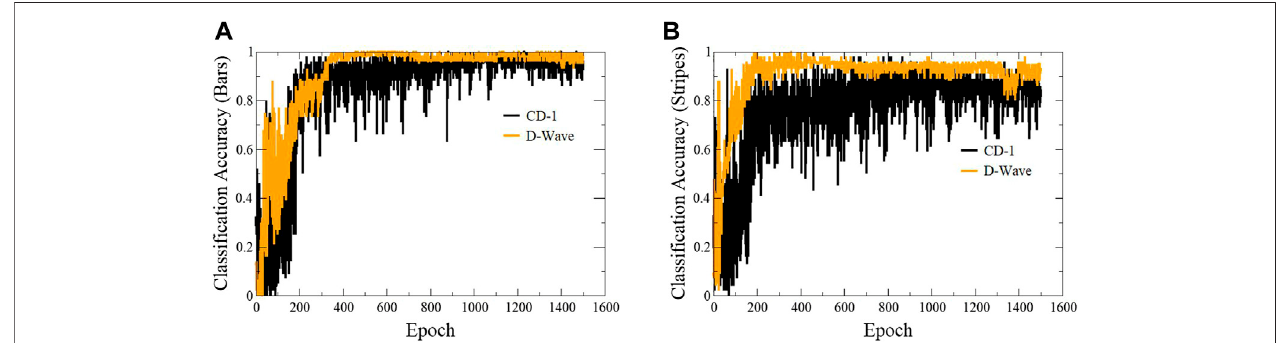
FIGURE 5 | Plots showing classi fi cation accuracy of individual classes with epoch. The gradient of log-likelihood was calculated using samples generated via contrastive divergence and D-Wave ’ s quantum annealer. A comparison of classi fi cation accuracy for both methods is presented for bars (A) and stripes (B) patterns.